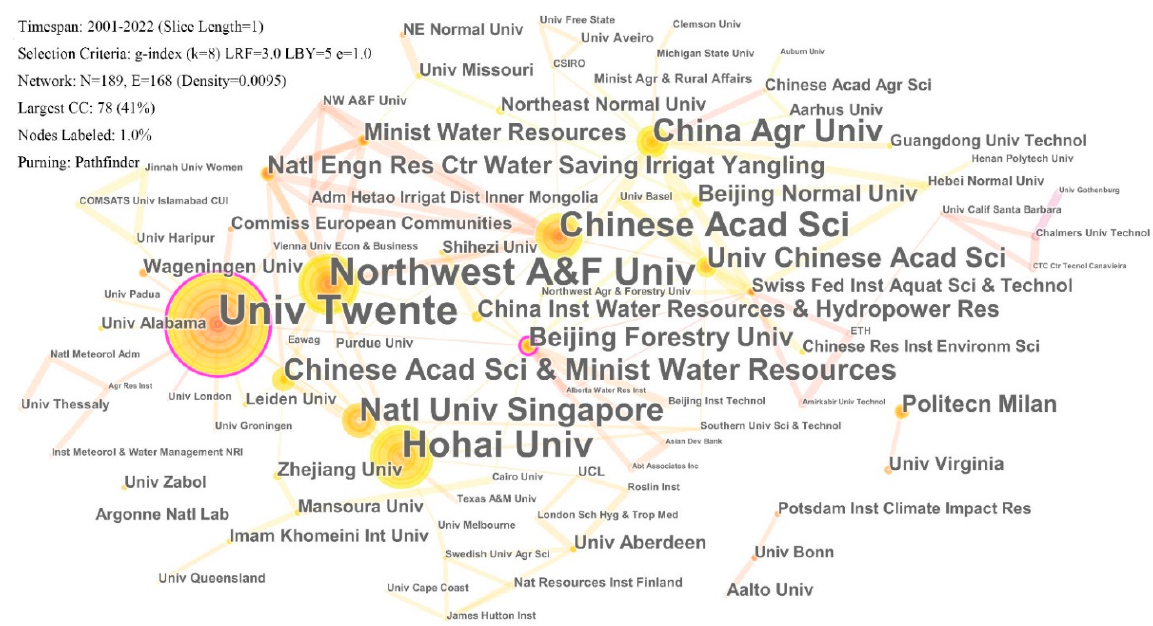
Figure 4. Cooperation network of institutions.